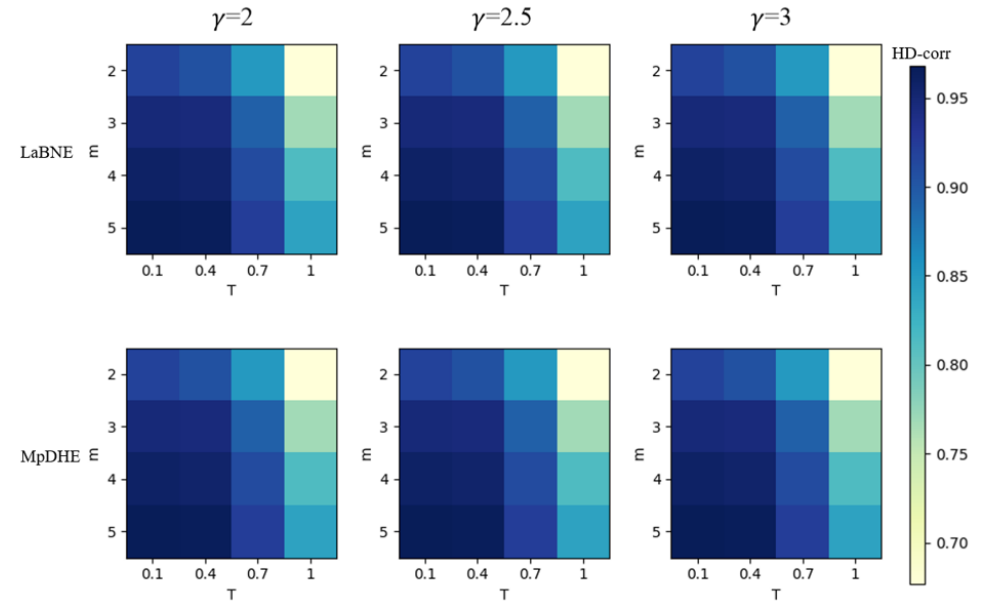
Figure 4. The embedding performance of networks with different